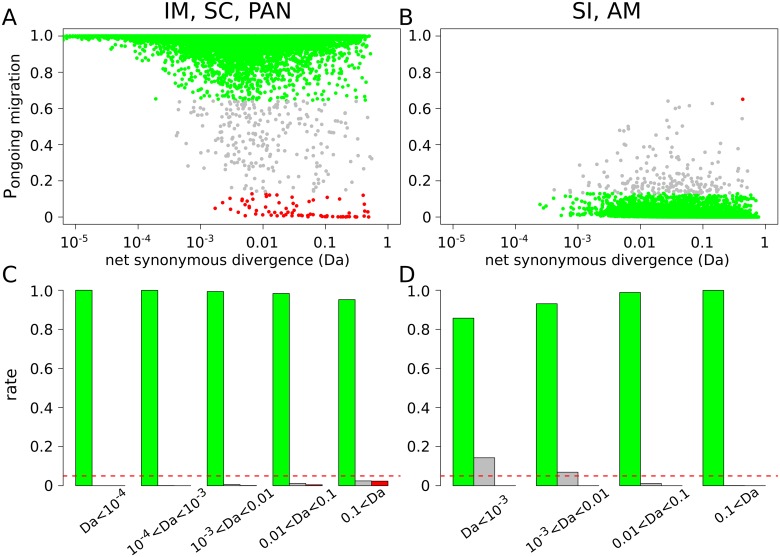
ABC analysis of randomly simulated datasets.Posterior probability Pmigration to support ongoing migration was estimated for a total of 116,000 simulated datasets across 16 models. A. Pmigration as a function of the net synonymous divergence Da. Dots represent datasets simulated under the IM, SC, and PAN models. The colors show datasets for which gene flow is correctly supported (green) or wrongly rejected (red). Grey dots represent datasets for which the robustness of the ABC analysis is <0.95. B. Pmigration as a function of the net synonymous divergence Da. Dots represent datasets simulated under the SI or AM models. The colors show datasets for which gene flow is correctly rejected (green; robustness ≥ 0.95) or wrongly supported (red; robustness ≥ 0.95). C. Proportion of true positives (green), false positives (red), and ambiguous analyses (grey) for different ranges of Da across IM, SC, and PAN datasets. Horizontal red line shows 5%. D. Proportion of true positives (green), false positives (red), and ambiguous analyses (grey) for different ranges of Da across SI and AM datasets.